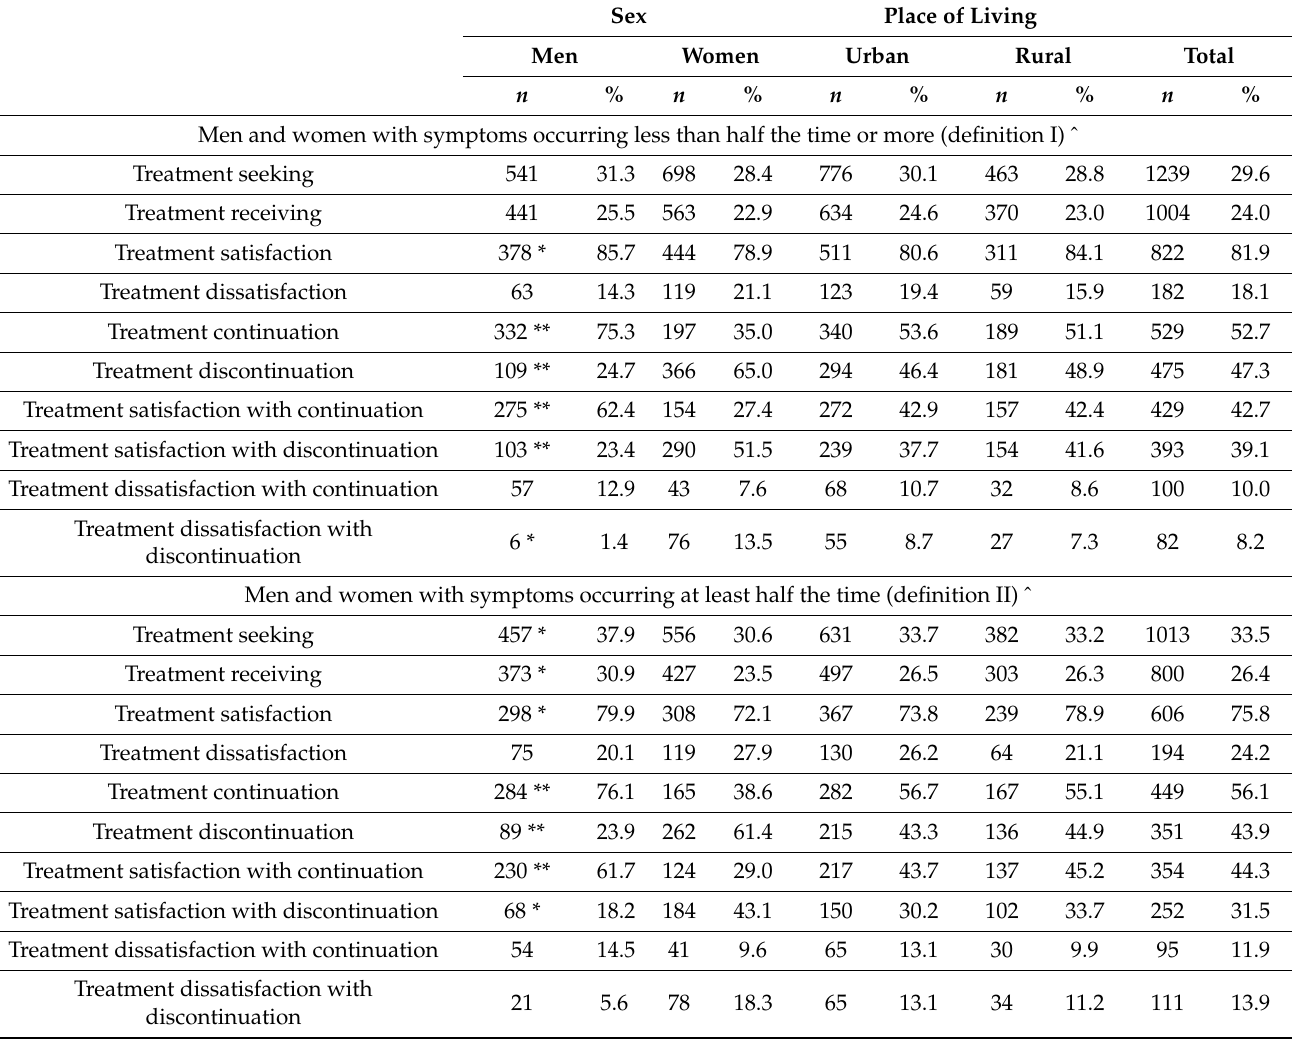
Table 2. Treatment-related